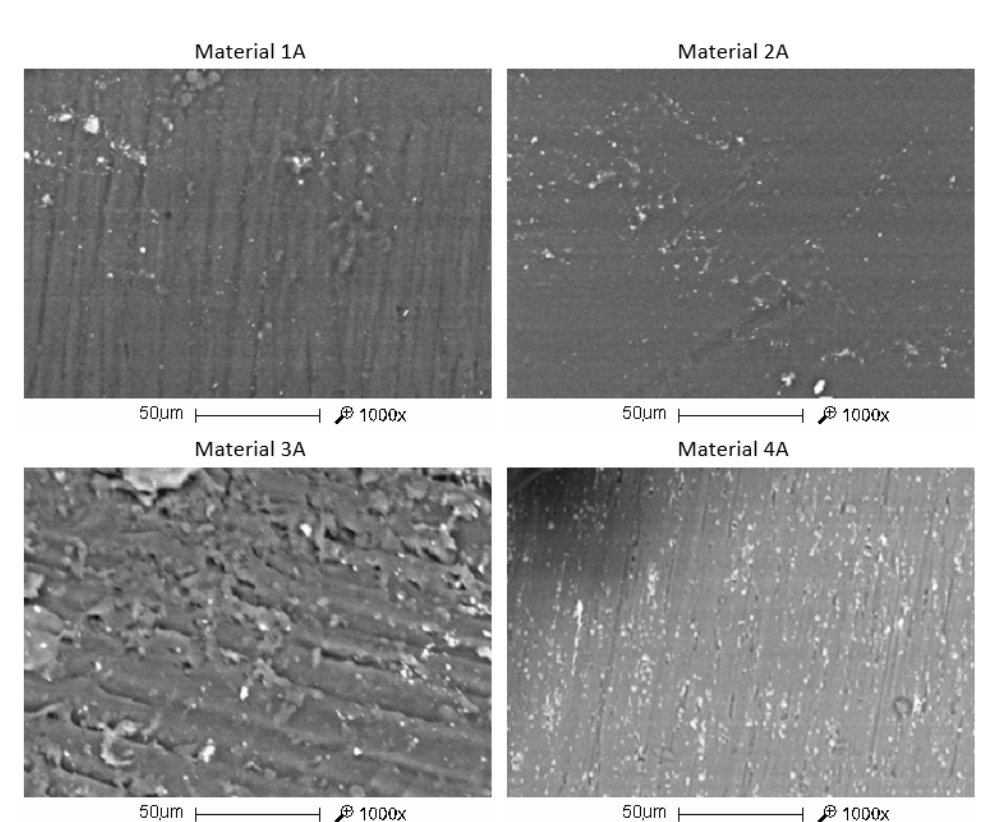
Figure 3. SEM micrographs of the surface of the tested materials (mag. 1000×).